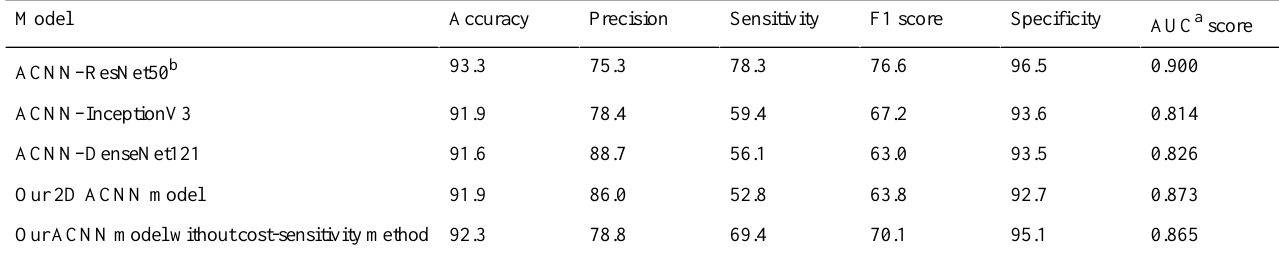
Table 3. Performance of the 2D artificial convolutional neural network (ACNN) model and other 3D models, constructed using free source codes available online, for 297 subjects with the novel coronavirus pneumonia lesion data set: prediction of event versus